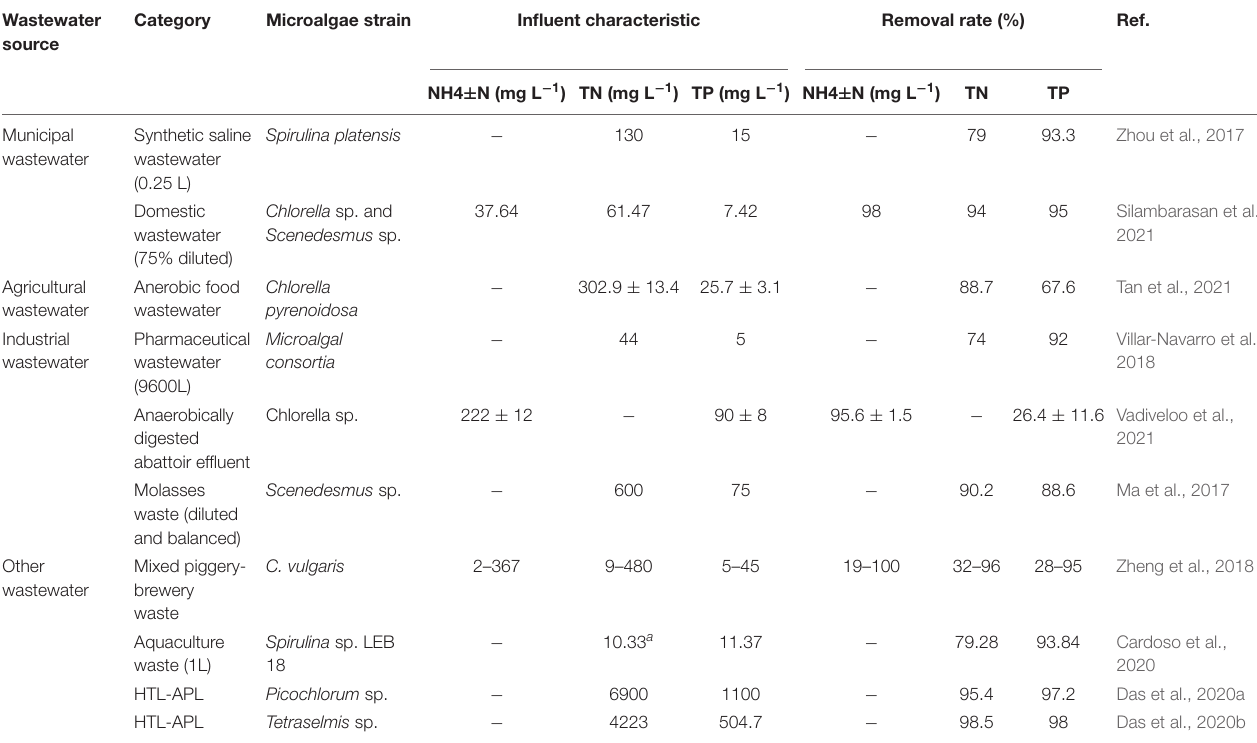
TABLE 2 | Comparison of nutrient removal rate of microalgae in different wastewater sources. Wastewater